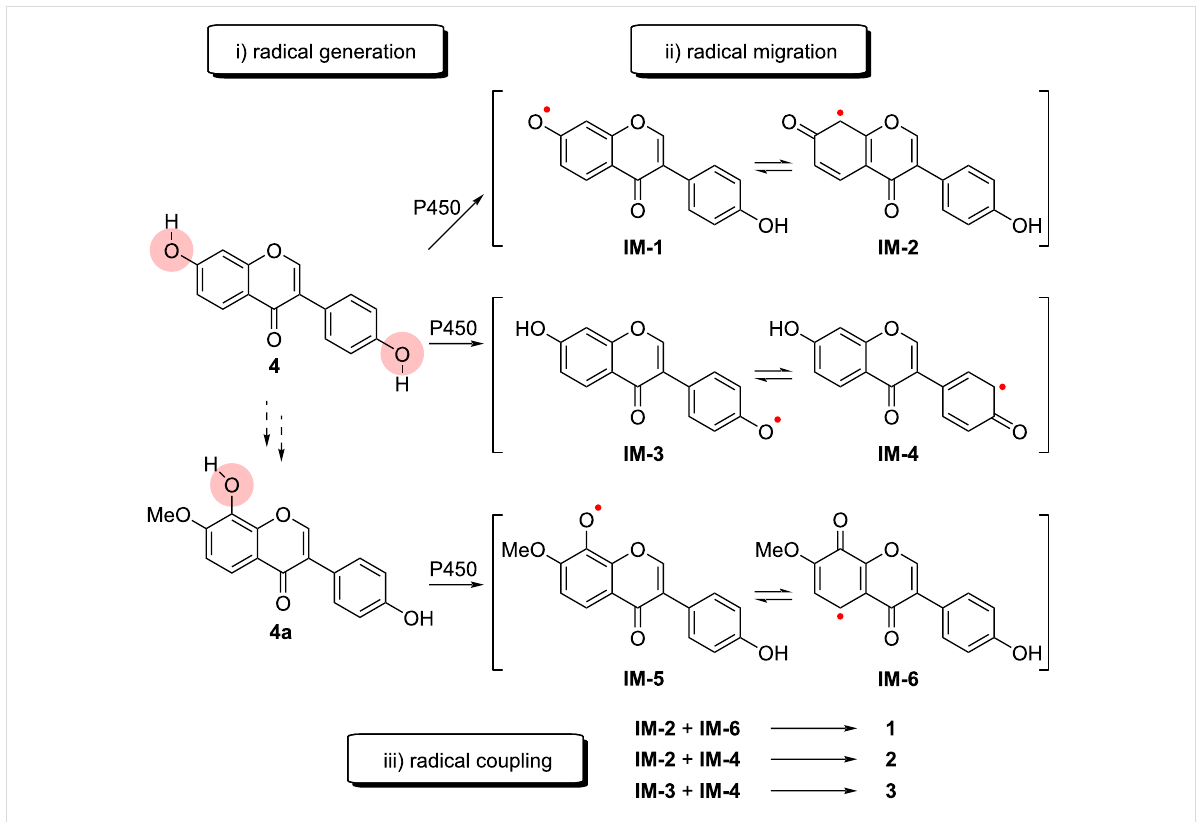
Scheme 2: Proposed mechanism of CYP158C1-mediated dimerization of